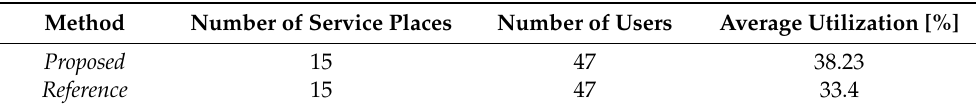
Table 4. A comparison of the average utilization of the service system for our method and the author’s